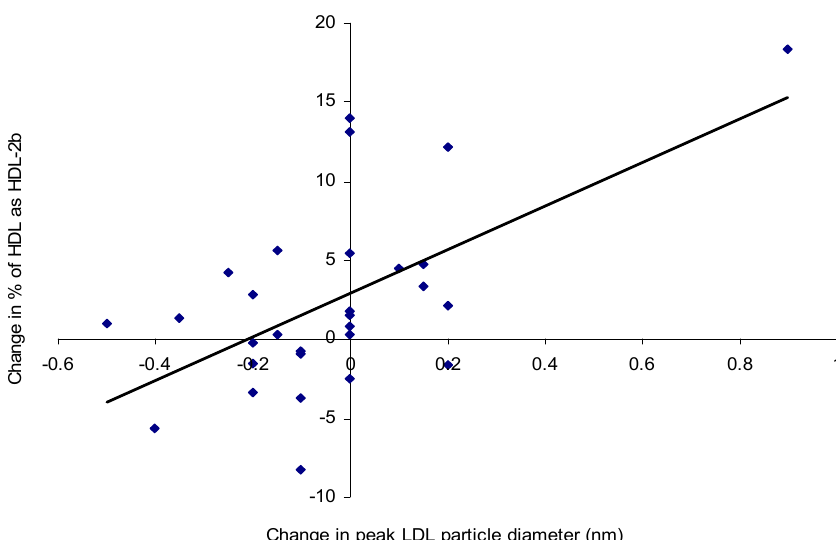
Figure 5. Scatterplot showing the relationship between the change in LDL particle diameter (nm) and the change in the proportion of HDL 2b following supplementation with 0, 0.35, 0.7, and 1 g/day n -3 LCPUFA from HiDHA™ tuna oil ( n = 29). R 2 = 0.34, p = 0.0008. 0 g/day group n = 12; 0.35 g/day group n = 15; 0.7 g/day group n = 13; 1.0 g/day group n = 13.